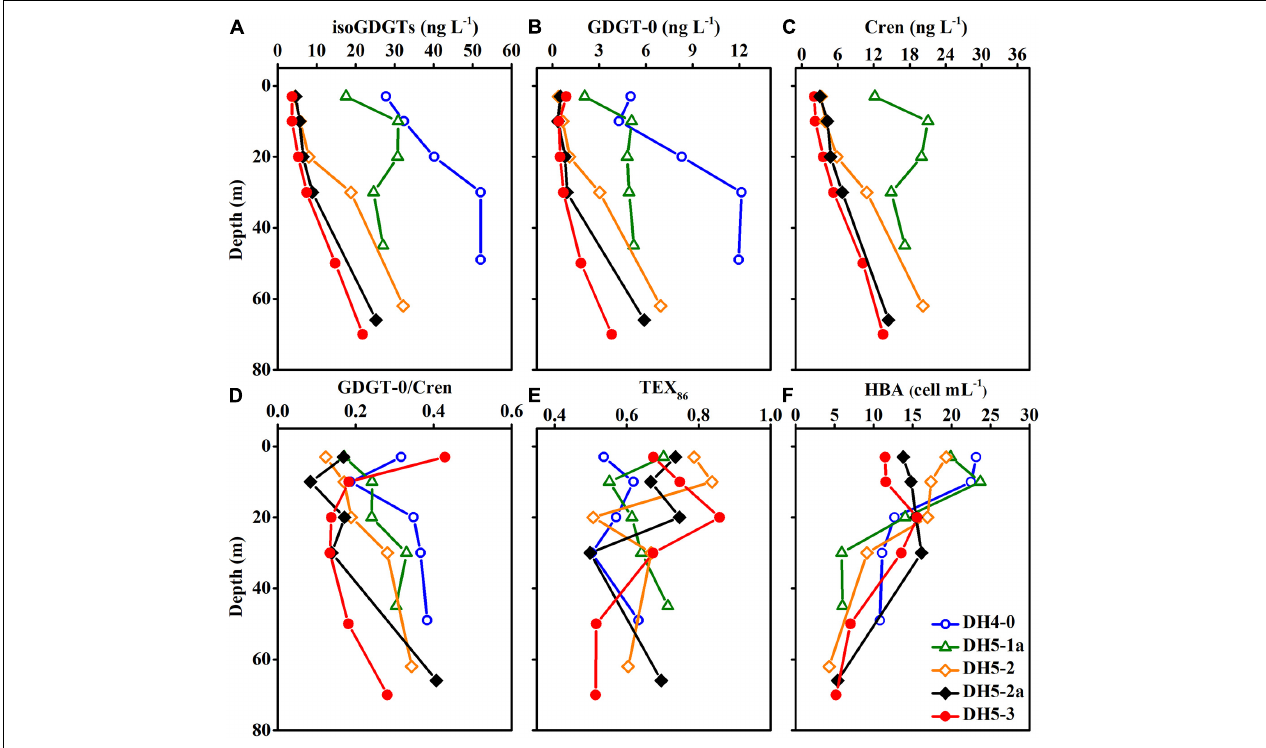
FIGURE 4 | Vertical distributions of (A) isoGDGTs, (B) GDGT-0, (C) Cren, (D) GDGT-0/Cren, (E) TEX 86 and (F) heterotrophic bacterial abundance